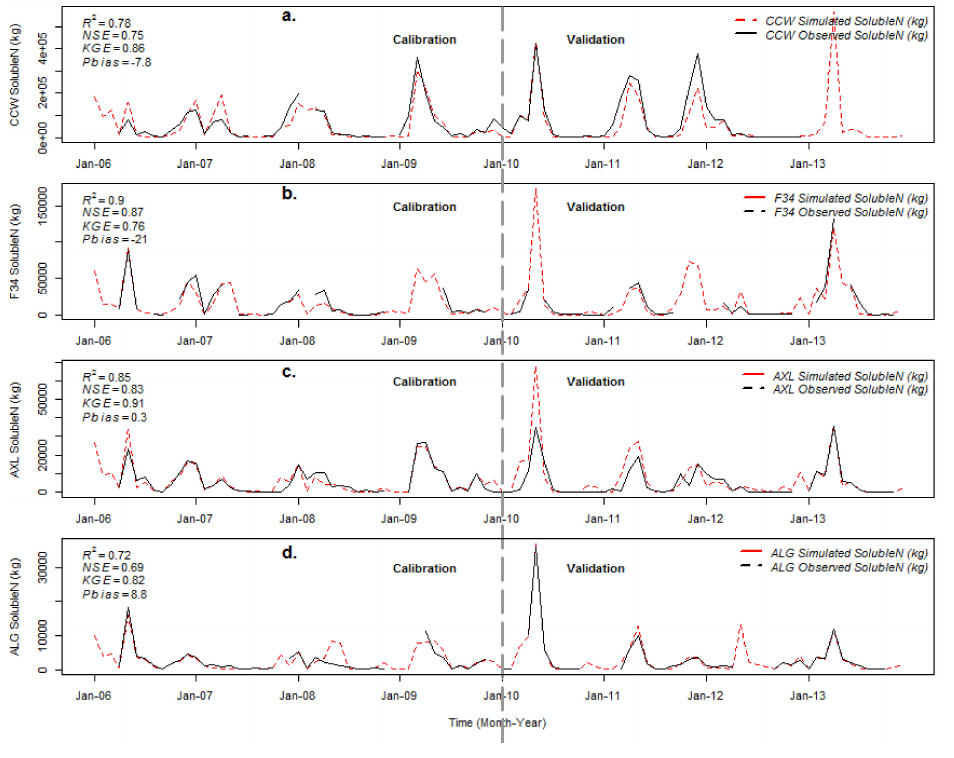
Figure A1. Monthly time series of simulated and observed soluble N for the calibration/validation period. ( a ) CCW, ( b ) F34, ( c ) AXL, and ( d )